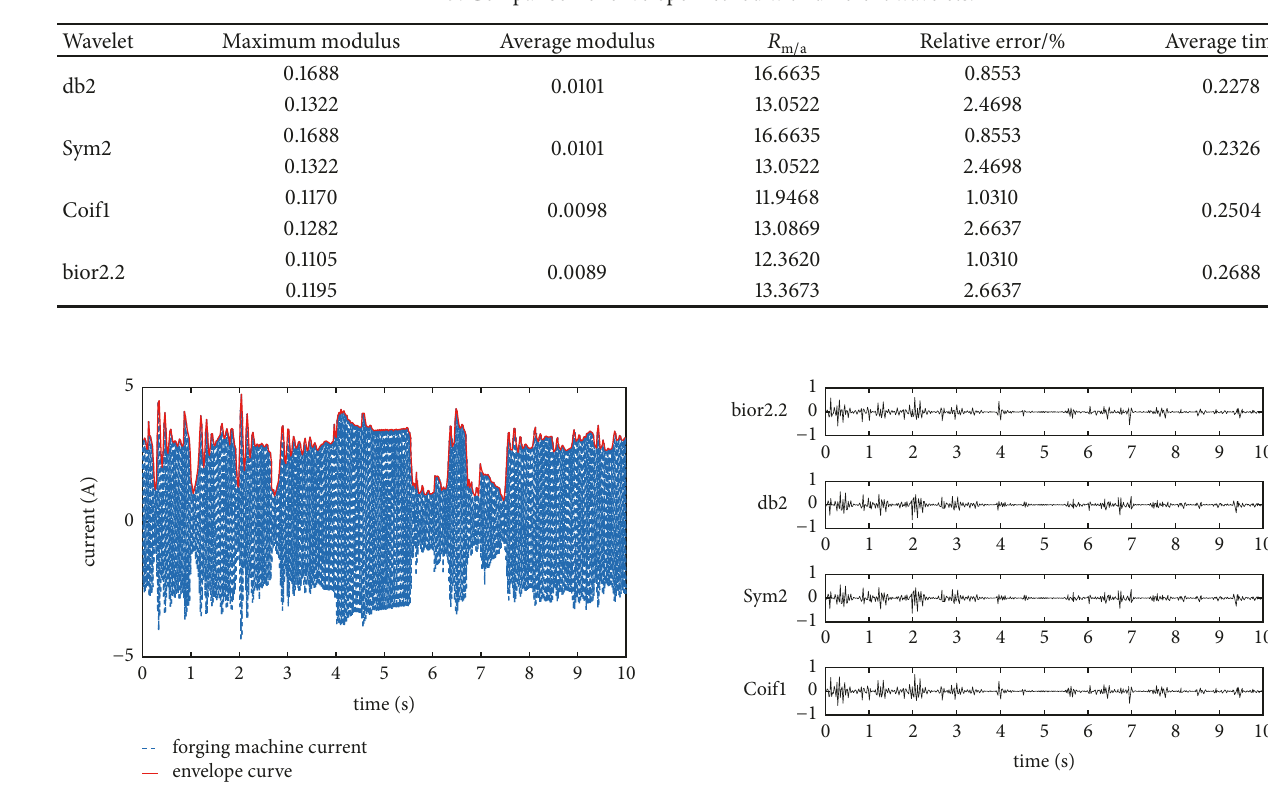
Figure 10: Forging machine current waveform and its upper envelope.